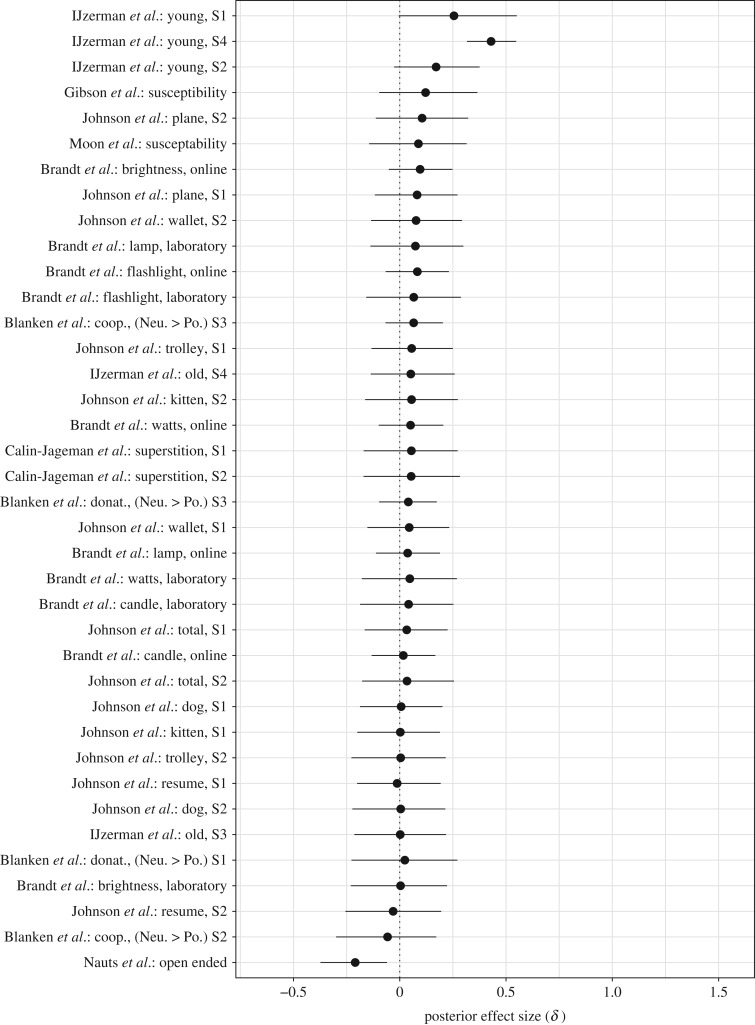
Individual results from a Bayesian random-effects analysis for the directed effect sizes δ from each of 38 experiments that used t-tests. The posterior medians are indicated as dots and the central 95% credible intervals as vertical lines. The effect sizes were estimated using a hierarchical model. Figure available at https://flic.kr/p/FqBRto, under CC license https://creativecommons.org/licenses/by/2.0/.